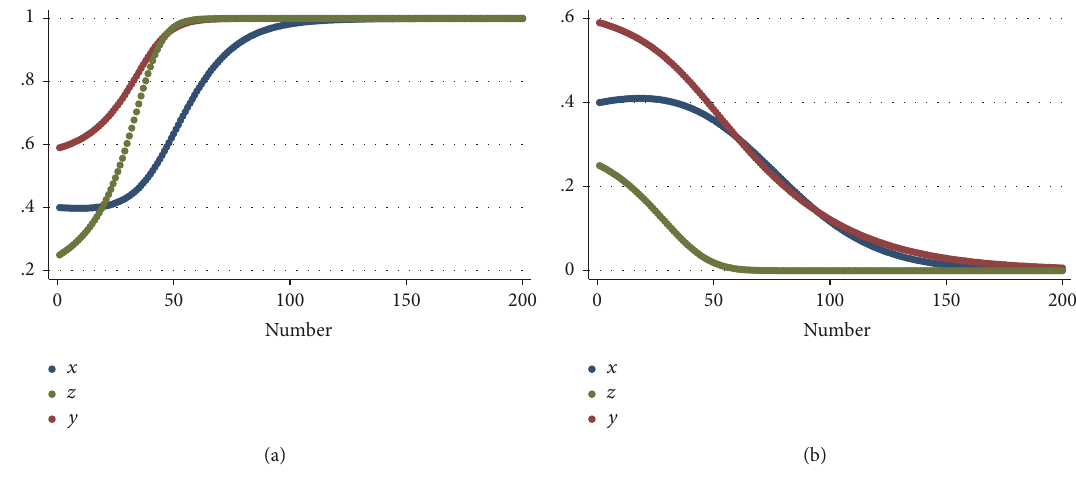
Figure 6: Simulation results when 𝑘